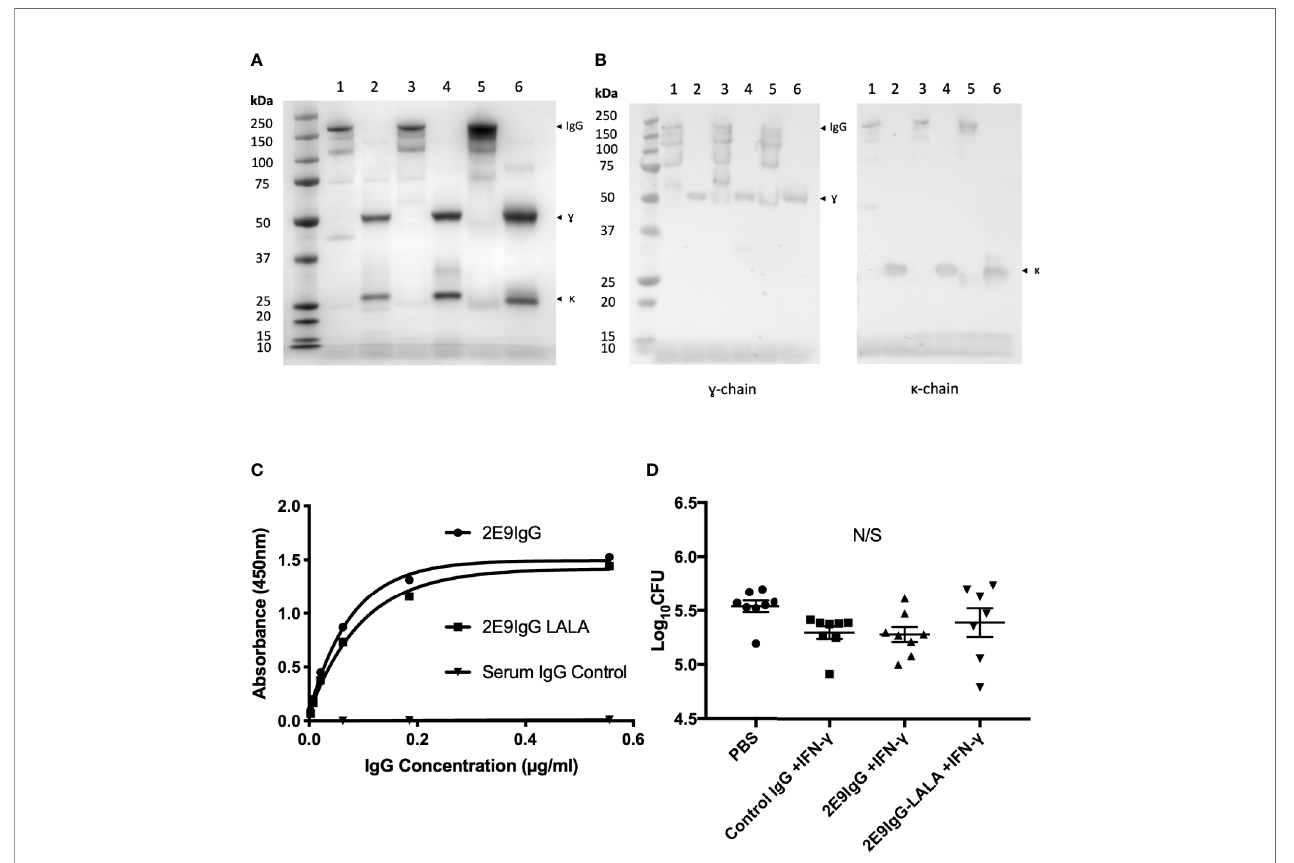
FIGURE 5 | Effect of 2E9IgG1 on aerosol MDR-TB challenge in CD64 transgenic mice. Recombinant 2E9IgG1 was characterized by SDS-PAGE Coomassie (A) and Western blot (B) using HRP conjugated anti-human IgG ( g -chain) secondary antibody. SDS-PAGE loading order was as follows: 1) 2E9IgG1 (NR), 2) 2E9IgG1 (R), 3) 2E9IgG1-LALA (NR), 4) 2E9IgG1-LALA (R), 5) human serum IgG (NR), and 6) Human Serum IgG (R). 2E9IgG1 and 2E9IgG1-LALA binding to Acr was investigated by ELISA (C) . CD64 transgenic BALB/c mice were challenged with 200 CFU MDR-TB by the nose only aerosol method, and treated with three doses of 2E9IgG1 + IFN- g . The fi rst dose consisted of 20 µg/animal of 2E9IgG + 1 µg/animal of IFN- g given intranasally. The second dose was given by the intraperitoneal route and consisted of 40 µg/animal of 2E9IgG1 + 2 µg/animal of IFN- g . The third dose was given intranasally, as the fi rst. Animals were culled 21 days after the MDR-TB challenge and lung CFUs were enumerated (D) . Error bars indicate SEM. N/S indicates no signi fi cance by one-way ANOVA with Tukey ’ s correction; n = 8. Mouse experiment performed